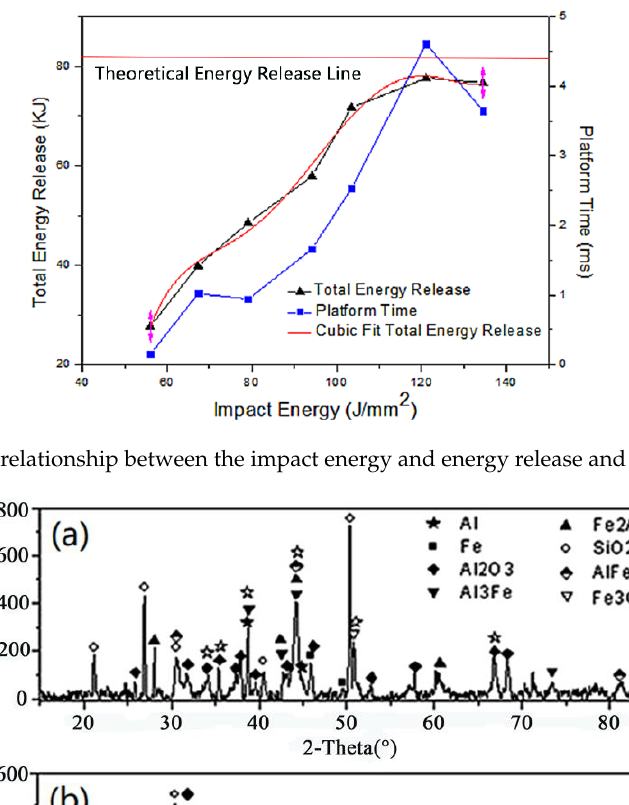
Figure 17. The pressure – time curve of Fe/Al energetic jets impacting the target plate with different thicknesses.